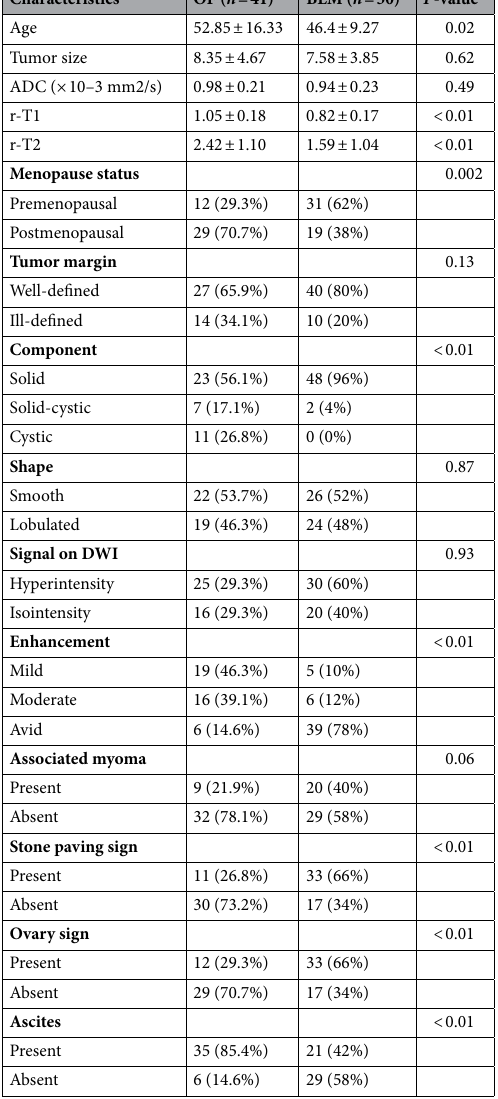
Table 3. Clinical and imaging features of Fibrothecoma and BLM. Values are given as n (%), mean ± SD (range). OF ovary fibrothecoma, BLM broad ligament myoma, ADC apparent diffusion coefficient, r-T1 relative T1 value, r-T2 relative T2